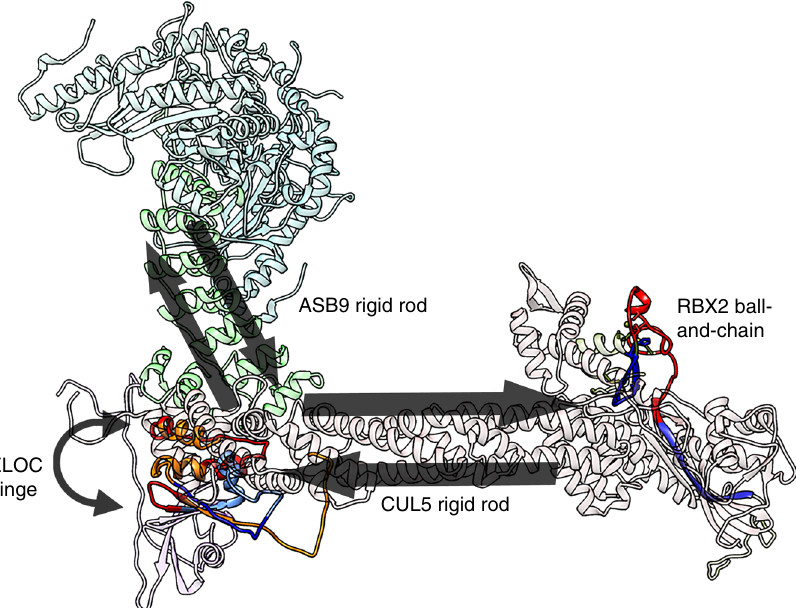
Fig. 7 The predicted allosteric path from substrate, CKB, through the CRL. CKB binding communicates through the substrate receptor, ASB9 which behaves as a rigid rod, through ELOB/C which behaves as a hinge, and fi nally through CUL5, which also behaves as a rigid rod. Both ASB9 and CUL5 appear to move as rigid bodies in the allosteric network. The network terminates in RBX2, which appears to be connected to CUL5 by a fl exible (very high amide exchange)